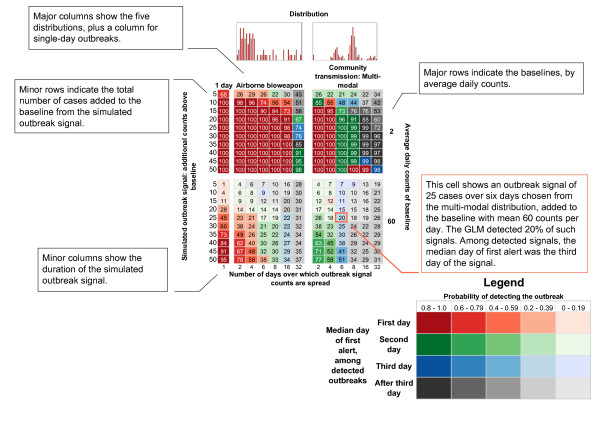
Guide to interpreting Figure 3.